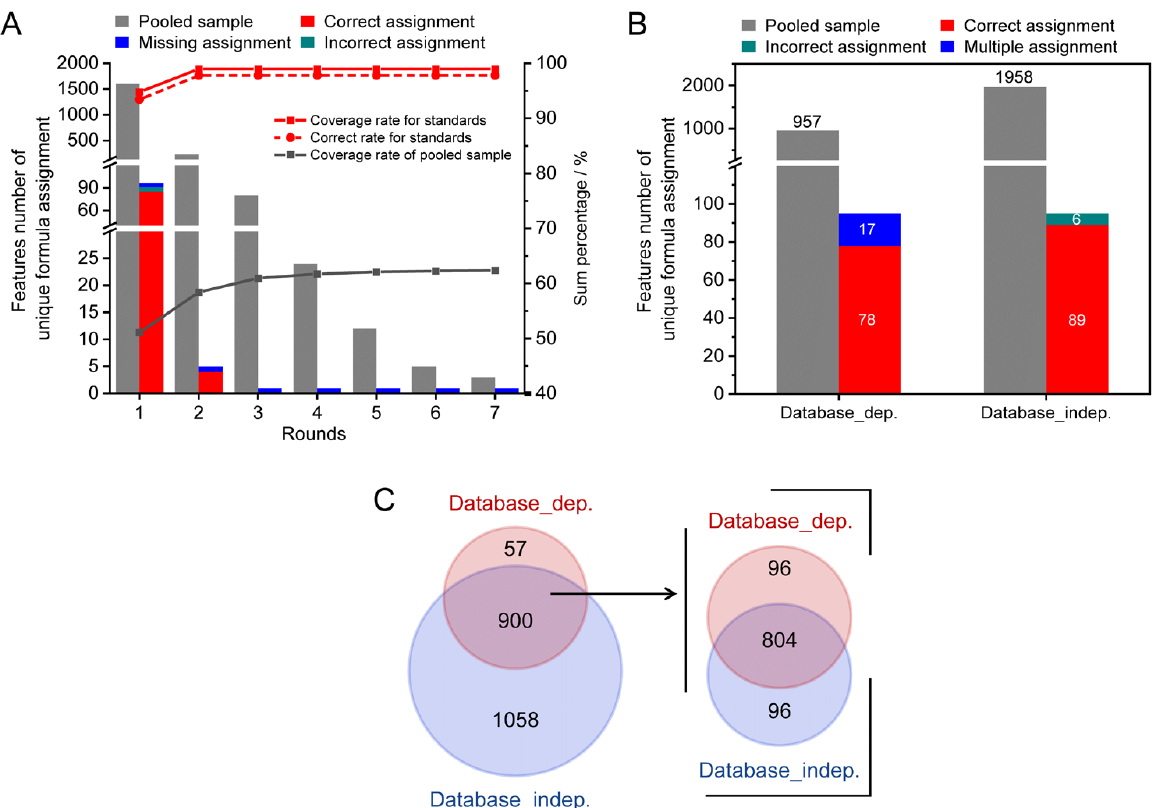
Figure 4. The method validation results using a spiked serum sample. ( A ) The coverage and accuracy rates of the developed method. ( B ) Comparison of assignment performance between the developed method and the database search. ( C ) The Venn diagram of assignment results of both methods for the spiked pooled serum sample.